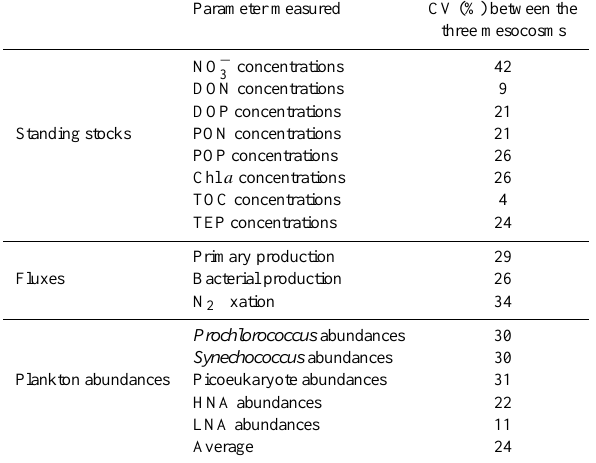
Table 1. Mean variation coefficients (CV = standard devia- tion × 100/mean; %) calculated for samples collected at the same time and the same depth in the three mesocosms. The CV derived from these calculations was averaged over the 23-day experiment. POP: particulate organic P. HNA stands for high nucleic acid bacte- ria, and LNA for low nucleic acid